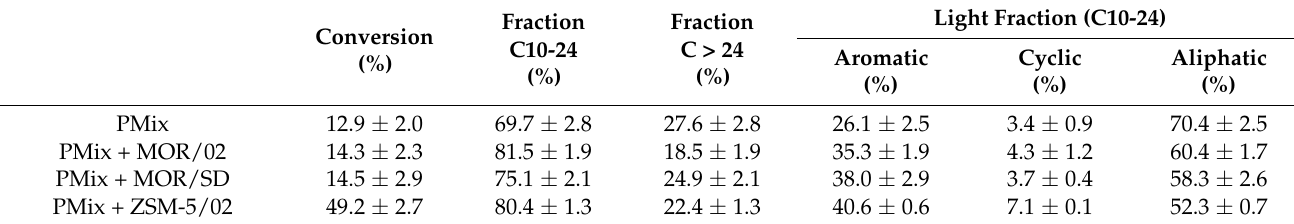
Table 6. Results of the non-catalytic PMix and catalytic